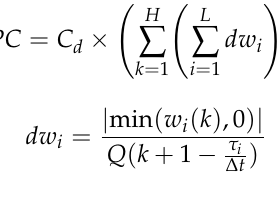
(20) The lower and upper bounds on the production level are defined by the following constraint at each period k: